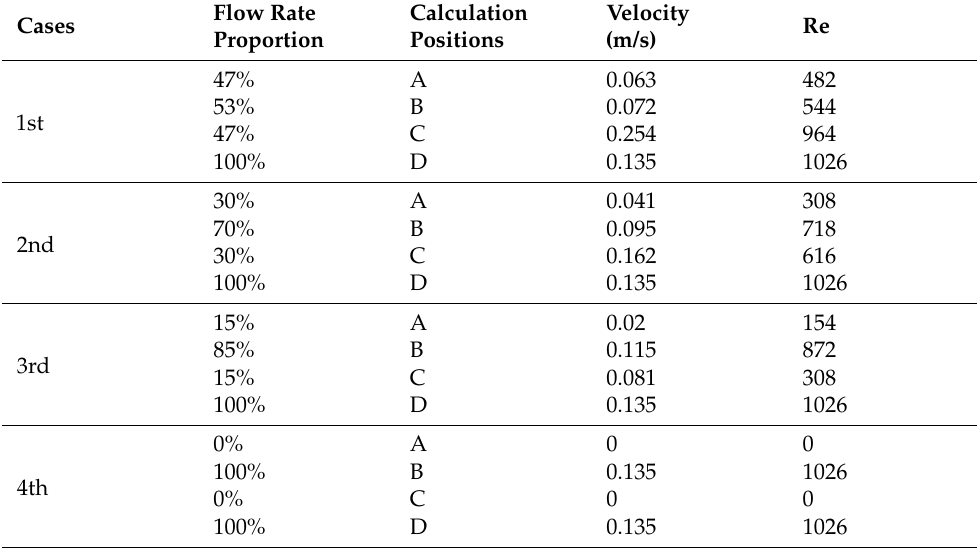
8 of 17 Figure 7. Area points of calculations. Table 2. Test case scenarios with calculation of velocities and Reynolds numbers. Cases Flow Rate